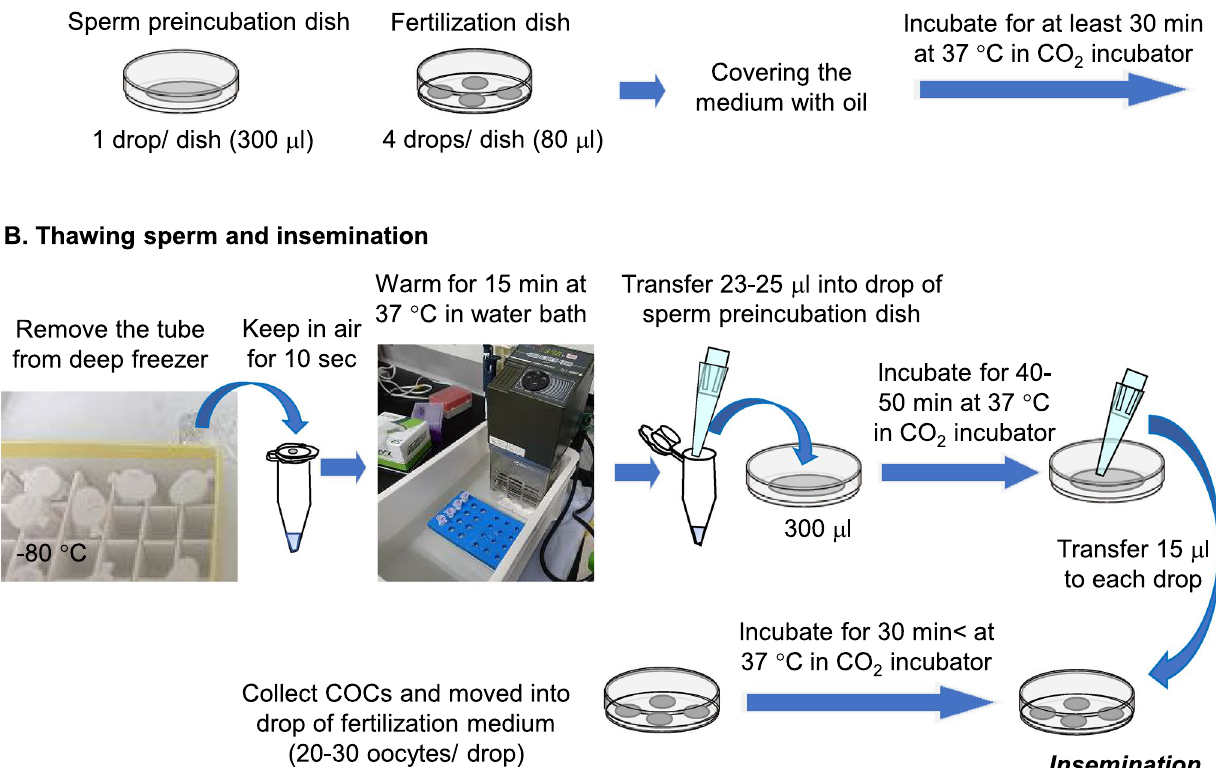
Figure 2. Schematic presentation of in vitro fertilization (IVF) using sperm frozen-thawed by the EQ